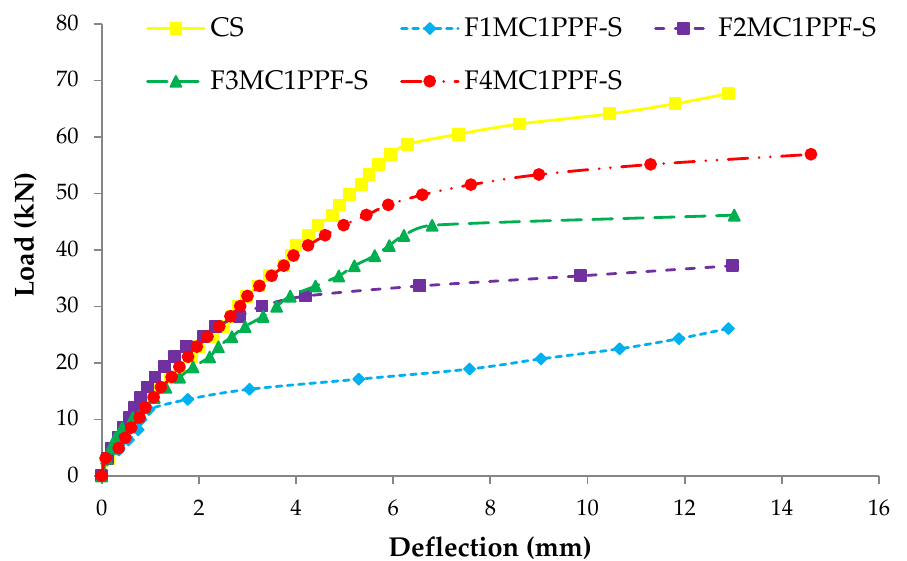
Figure 12. Comparison of load-deflection of group B1 with CS slab.